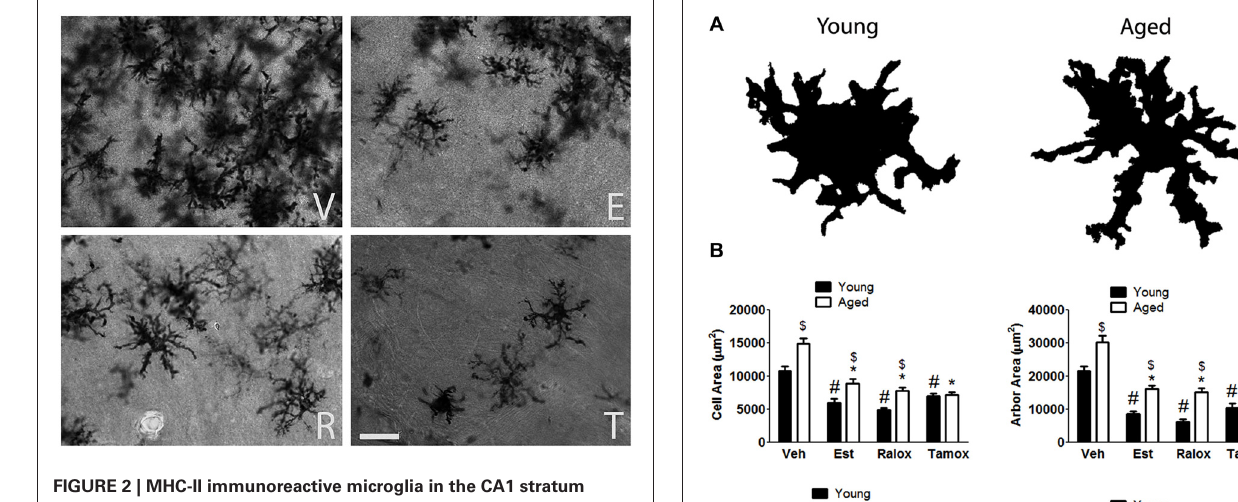
FIGURE 2 | MHC-II immunoreactive microglia in the CA1 stratum radiatum at a distance of approximately 100–200 µ m from the lateral border of the wound in aged animals . The panels illustrate representative examples from ovariectomized aged rats after administration of (V) vehicle, (E) estradiol, (R) raloxifene or (T) tamoxifen. All figures are at the same magnification. Scale bar, 50 um.